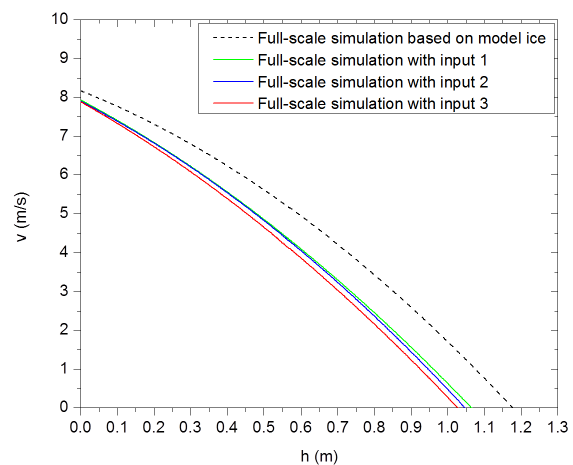
Figure 29: h − ν curve obtained when the vessel is run- ning astern (the full-scale simulation results with different ice